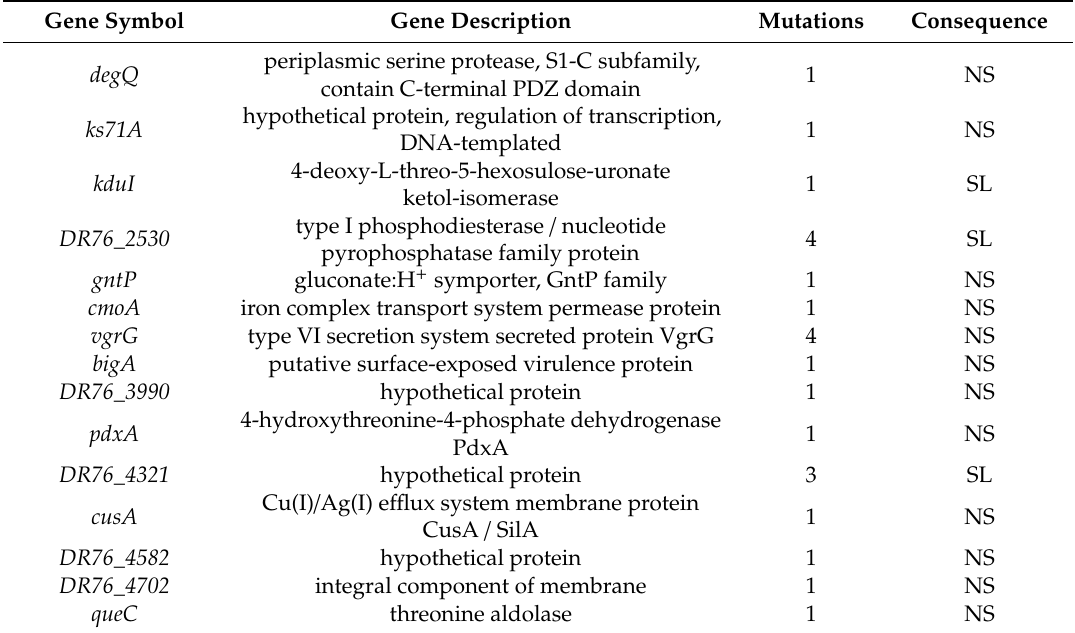
Figure 3. Protein–protein interactions of E. coli ATCC25922 induced by sub-MICs of OLA generated following analysis of significantly di ff erent peptides input into the STRING database. The figure shows the protein–protein interactions networks that resulted from co-di ff erentially expressed genes. “ ” represent known interactions from curated databases, “ ” represent known interactions have been experimentally determined; “ ” represent predicted interactions of gene neighborhood, “ ” represent predicted interactions of gene fusions, “ ” represent predicted interactions of protein homology. “ ” represent interactions of gene textmining, “ ” represent predicted interactions of gene co-expression, “ ” represent interactions of gene co-occurrence. Table 2. Genes with non-synonymous mutation and / or single-point deletion in E. coli ATCC25922 both induced by 1 / 2 × MIC and 1 / 10 × MICof